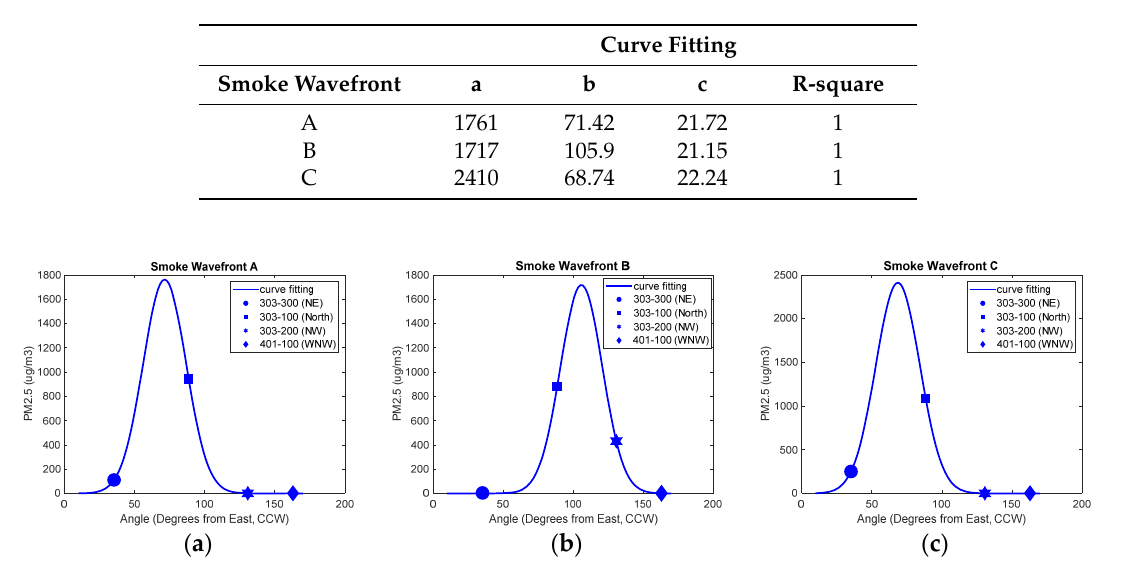
Figure A1. ( a ) Gaussian fitting of smoke wavefront A; ( b ) smoke wavefront B; ( c ) smoke wavefront C. Symbols indicate measured data at the four sensor locations at the time of peak intensities.